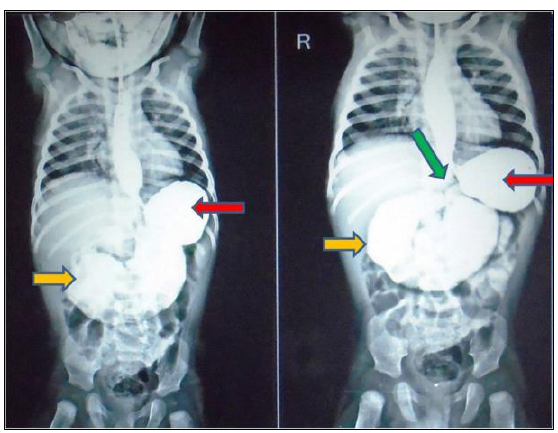
Figure 4: Upper gastrointestinal contrast study (the images taken at 5 and 15 minutes) showing gastroesophageal reflux, dilated stomach (red arrow) and markedly distended duodenum (orange arrow) up to DJ junction (green arrow). Caliber of jejunum and rest of the distal bowel appears